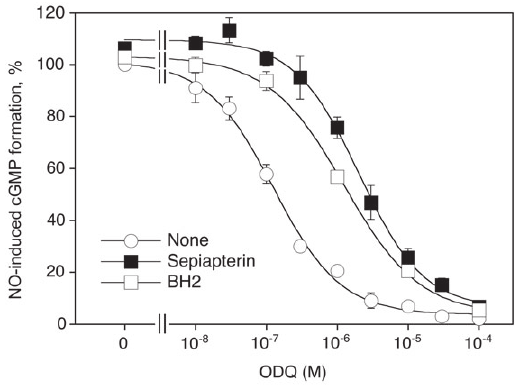
Figure 2 Effects of pteridines on oxidative inactivation of sGC induced by ODQ. Endothelial cells were pretreated in culture medium for 24 h with 0.1 mM sepiapterin or for 1 h with 0.1 mM BH2. Then, cells were washed, preincubated for 15 min with increasing concentrations of ODQ, for 4 min 1 μ M DEA/NO, and cGMP formation was determined of 3 – 5 independent